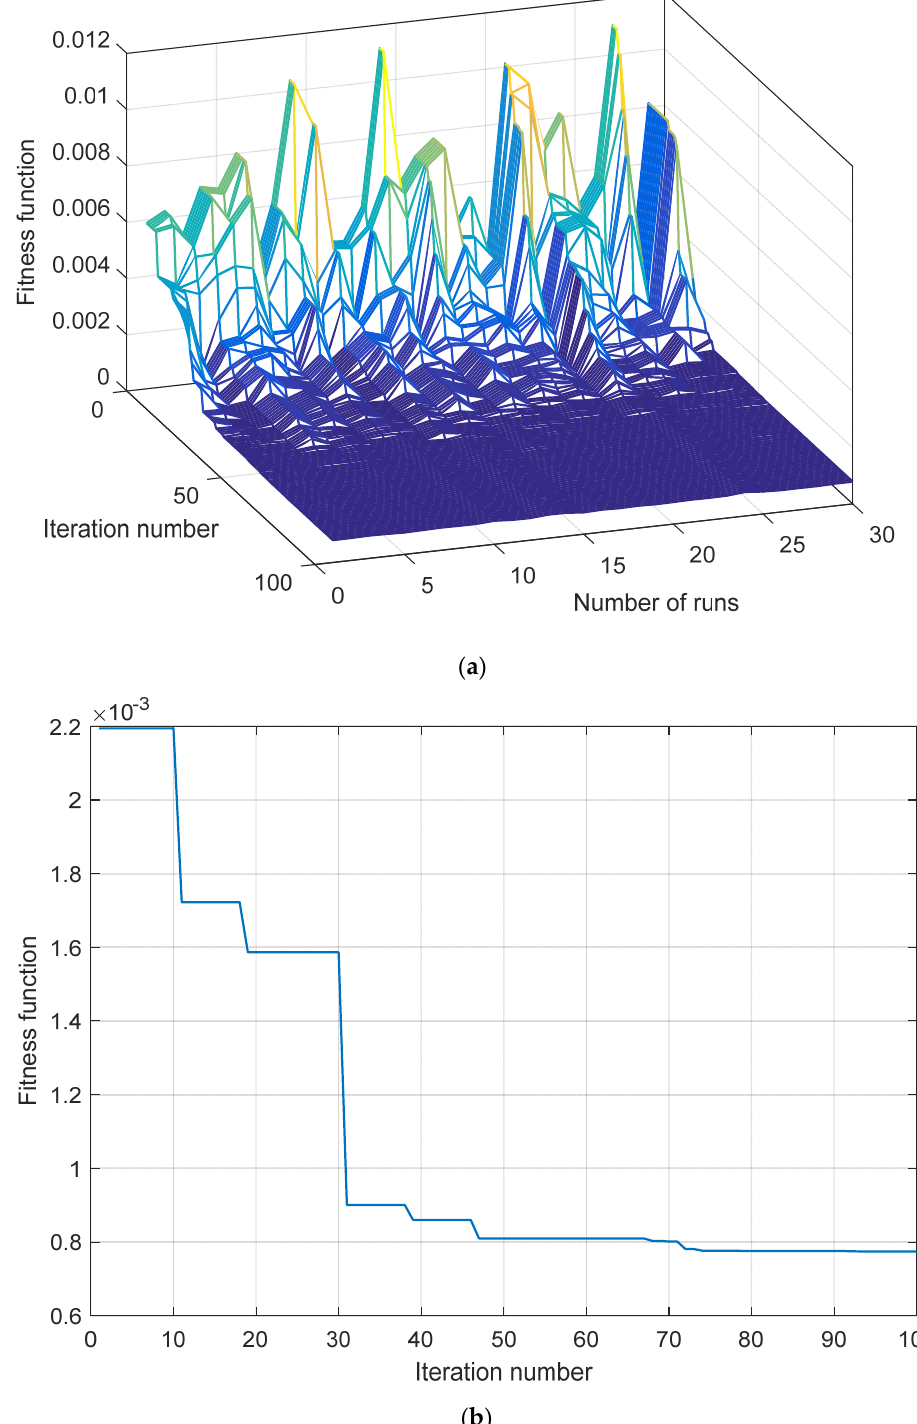
Figure 13. Particle swarm optimization (PSO): ( a ) fitness function for a different number of runs, and ( b ) mean fitness value versus iteration number.